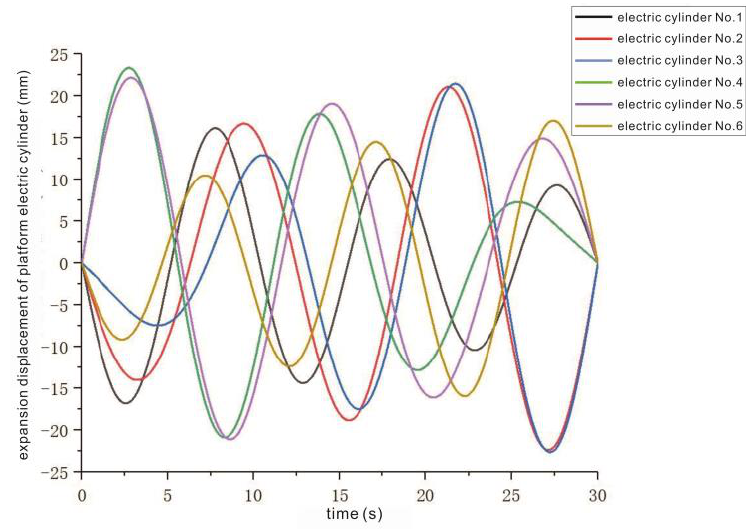
Figure 9. Displacement diagram of the platform electric cylinder.